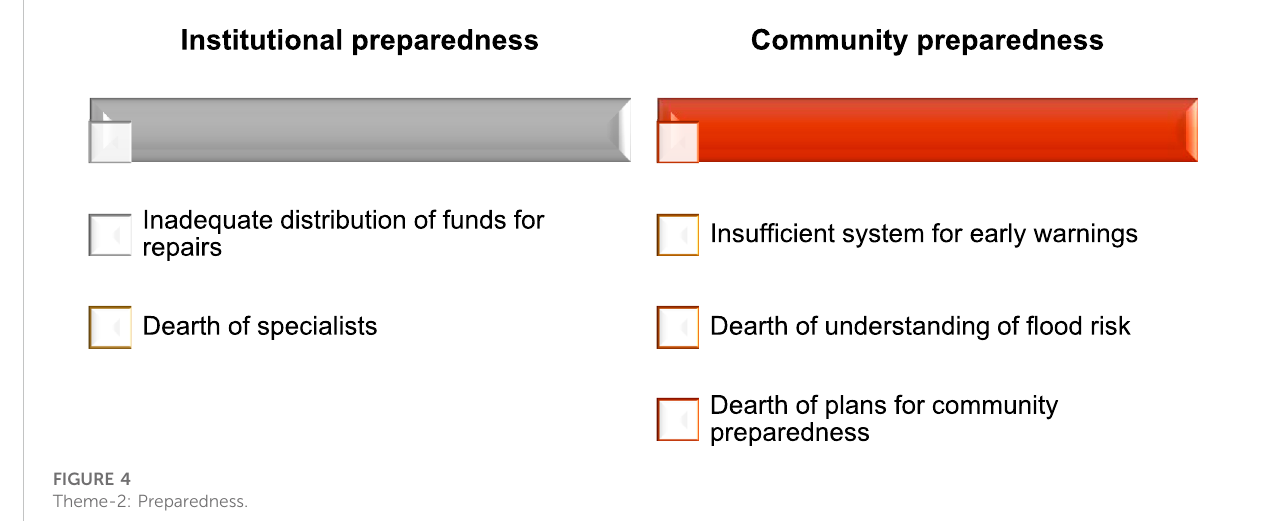
FIGURE 4 Theme-2: